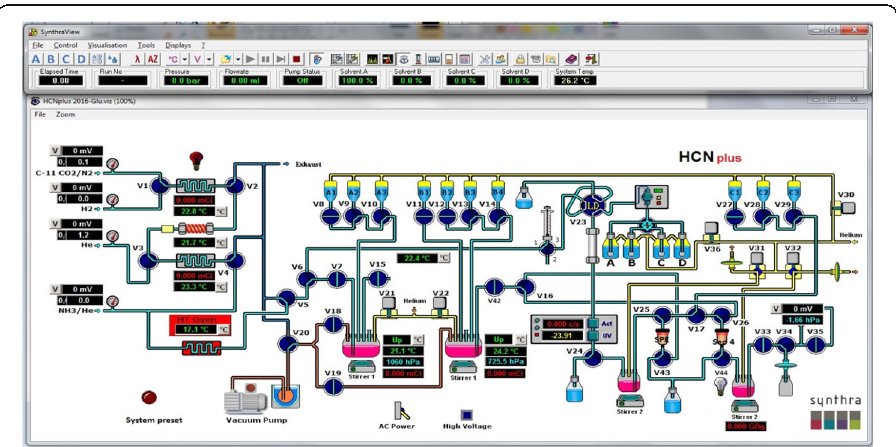
Fig. 1 Graphic interface of Synthra HCN Plus automated synthesis